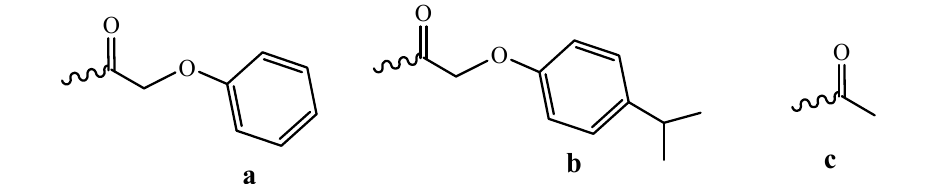
Figure 4. Labile protective groups for nucleoside heterocyclic bases: ( a ) phenoxyacetyl, ( b ) p-isopropylphenoxyacetyl, ( c )